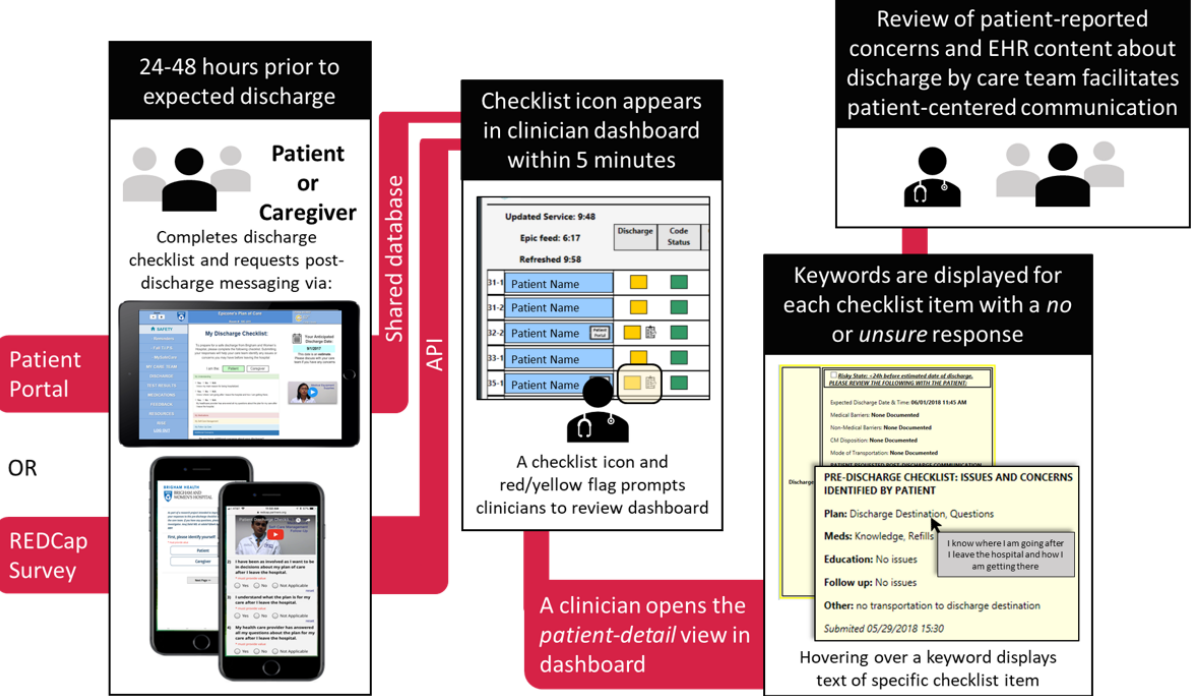
Figure 3. Checklist submission and review. EHR: electronic health